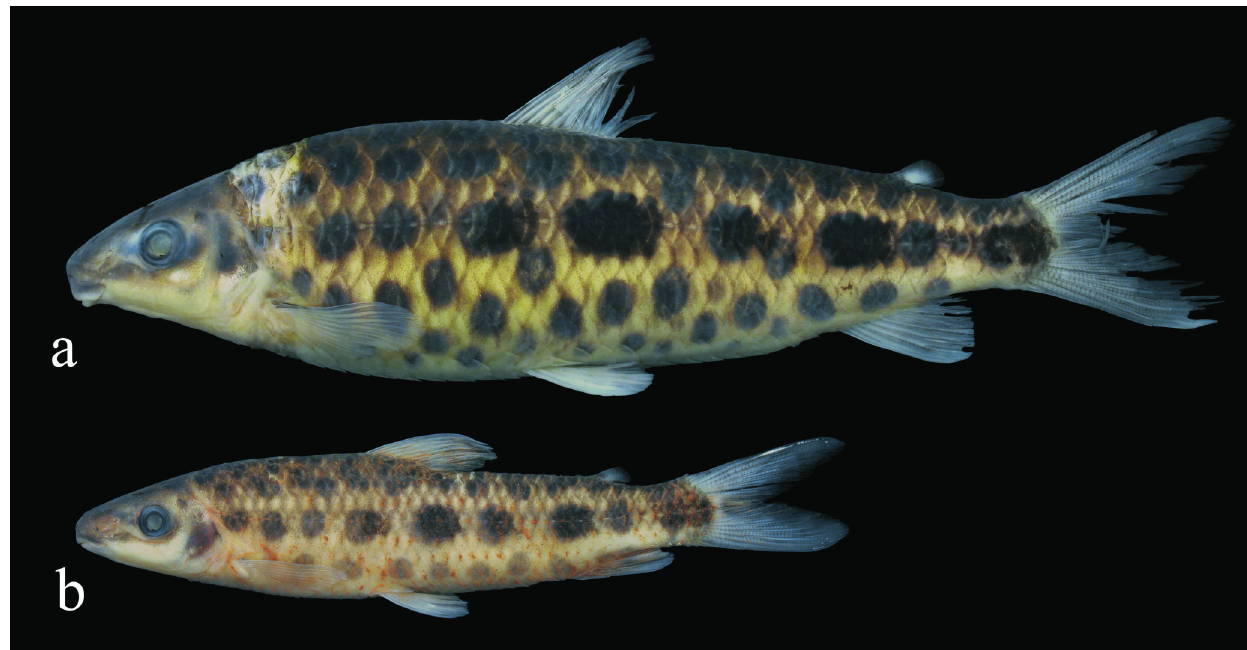
Fig. 1. Leporinus guttatus , a - holotype, MZUSP 97100, 107.5 mm SL, b - paratype, MZUSP 96865, 81.3 mm SL, Brazil, Altamira, Pará State, rio